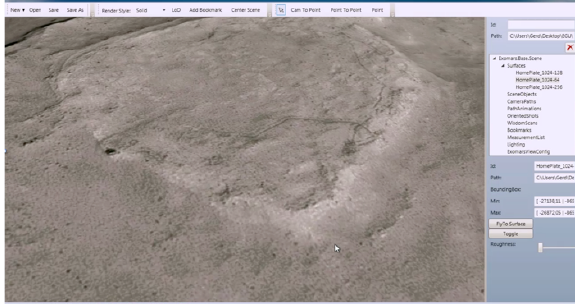
Figure 3 3D visualisation from PRo3D® of 5cm SRR over the MER-A Homeplate area. DEM courtesy of